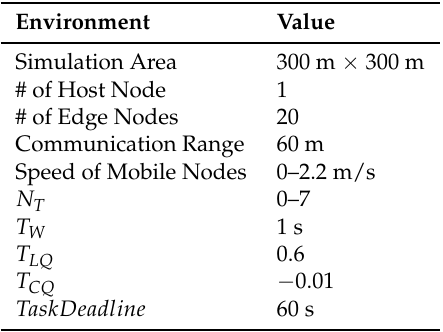
Table 1. Simulation environment and parameters.